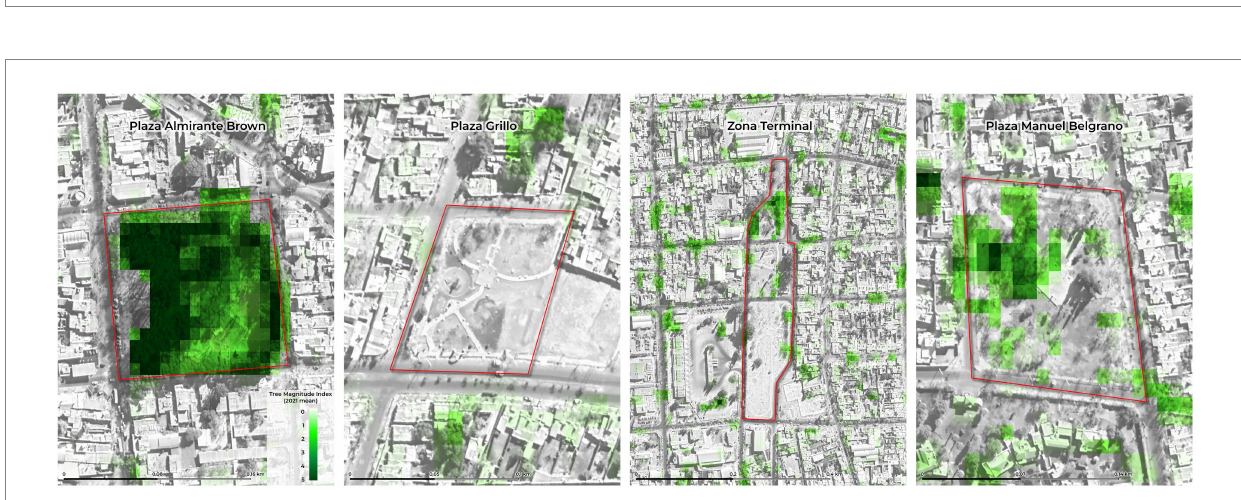
FIGURE 2 Mean Tree Magnitude Index (TMI) for four of the 34 sampled squares from San Juan City (San Juan, Argentina).